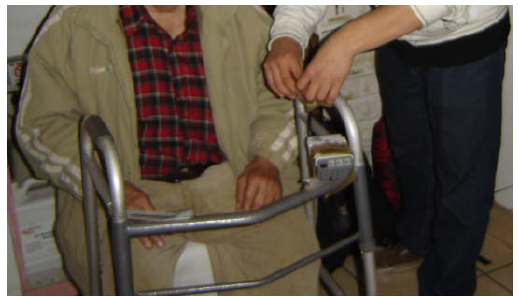
Figure 8. Installation of the pressure sensors on the handlebars of the elder’s walking aid for the identification of the ‘Get up without assistance’ situation of